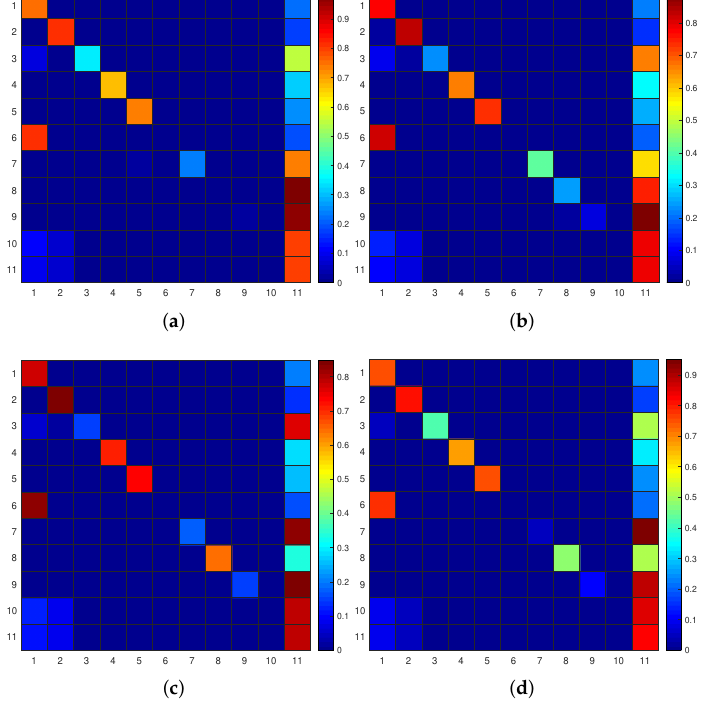
Figure 10. Confusion matrixes using different approaches. ( a ) FS ( ws = 15) + FV. ( b ) FS ( ws = 20) + DWN ( ρ = 0). ( c ) FS ( ws = 60) + DWN ( ρ = 0.1). ( d ) DS + DWN ( ρ =